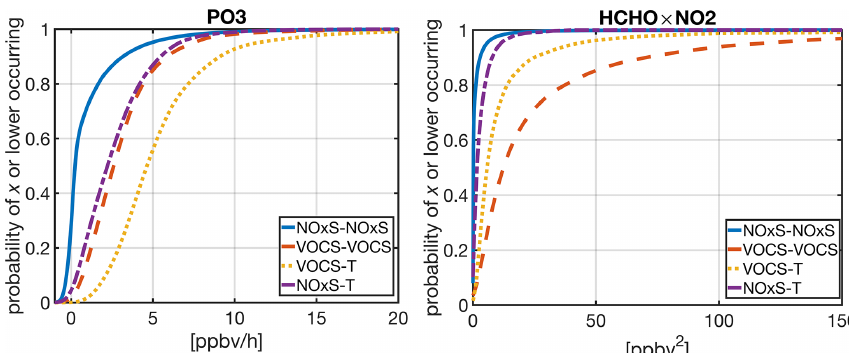
Figure 4. Cumulative distribution functions of PO 3 and HCHO × NO 2 simulated by the box model constrained by NASA’s aircraft observa- tions. Four regions are shown: NO x -sensitive–NO x -sensitive, NO x -sensitive–transitional, VOC-sensitive–transitional, and VOC-sensitive– VOC-sensitive. The first name of the regime is based on the baseline (ln(LRO x / LNO x ) = − 1.0), whereas the second one follows those de- fined in Duncan et al. (2010): VOC-sensitive if HCHO / NO 2 < 1, transitional if 1 < HCHO / NO 2 < 2, and NO x -sensitive if HCHO / NO 2 > 2.